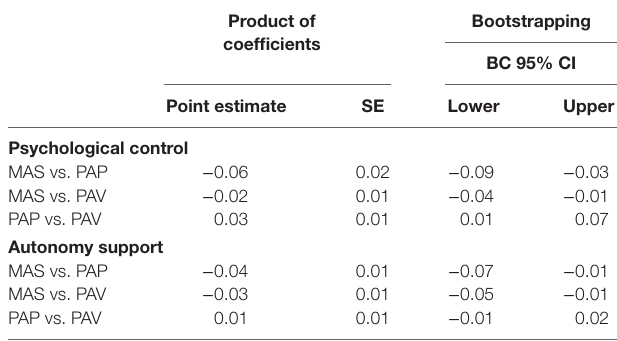
Table 3 | Indirect effect of parenting on students’ maladaptive academic functioning through achievement goal orientations.